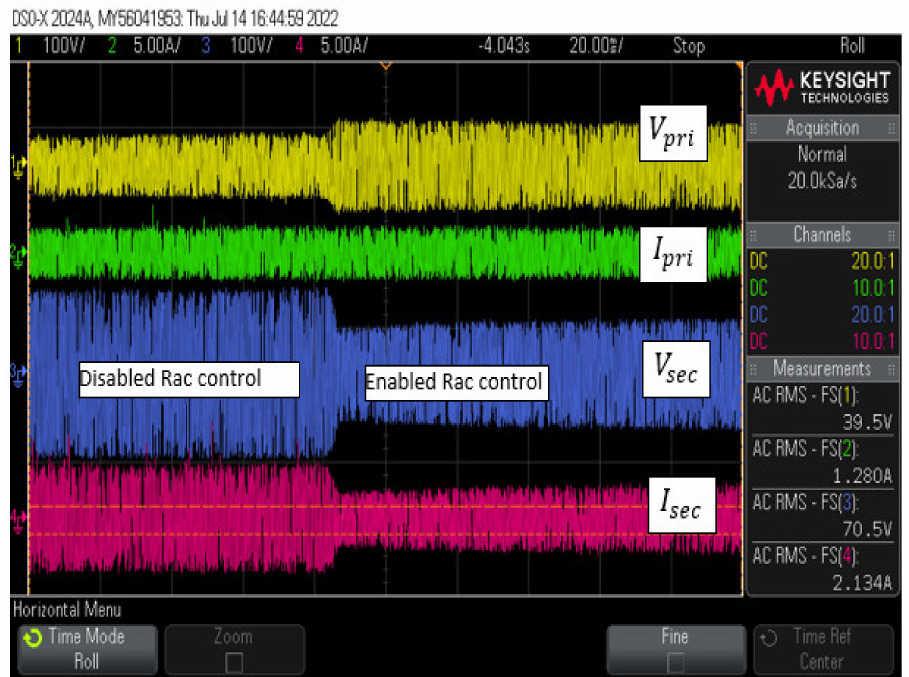
Figure 24. Transmitter/receiver coil current/voltage at Vo = 40 V with R dc = 150 Ω connected when rectifier R ac = 38 Ω feedback control is disabled vs.